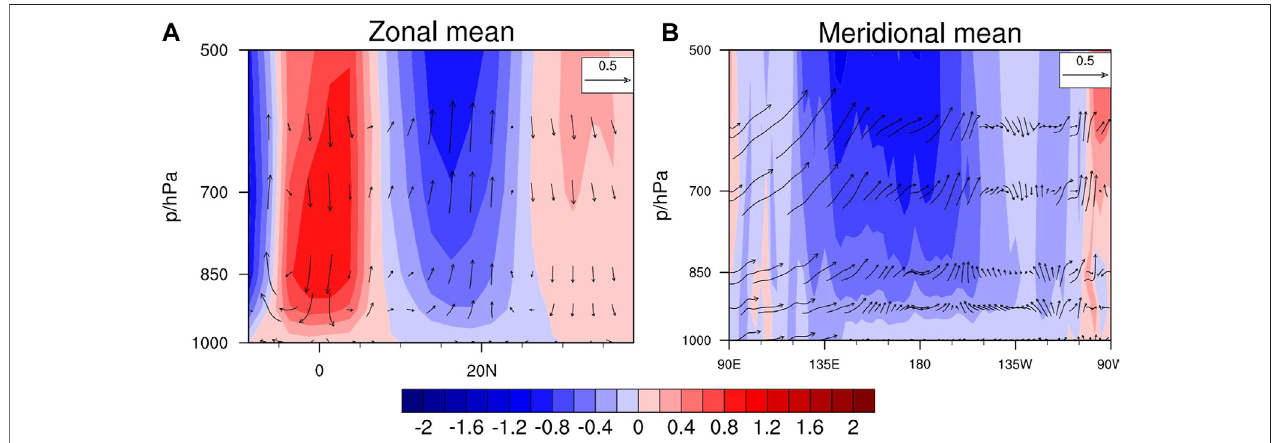
FIGURE 10 | The changes of the (A) zonal mean (120 – 180 ° E) and (B) meridional mean (10 – 20 ° N) vertical wind anomaly (m/s) during strong EP events in the following summer (vectors are for the changes of wind anomaly, and the shadings are for the anomalies in historical